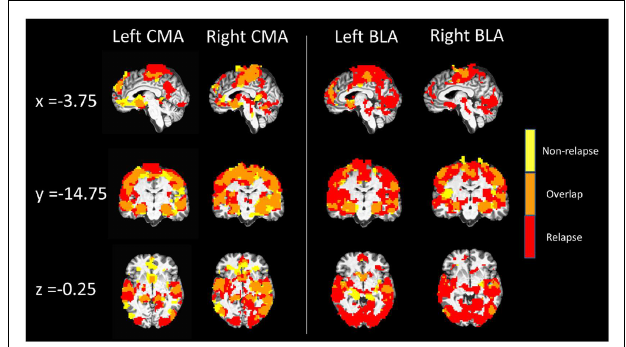
FIGURE 2 |Whole-brain resting state functional connectivity maps of left and right CMA and BLA seeds for relapse ( n = 24, red) and non-relapse ( n = 21, yellow) groups . Maps are overlaid for display purposes, with regions where whole-brain connectivity group maps overlapped displayed in orange, p corrected = 0.01, z (21) > 3.3 and a cluster size of 55.